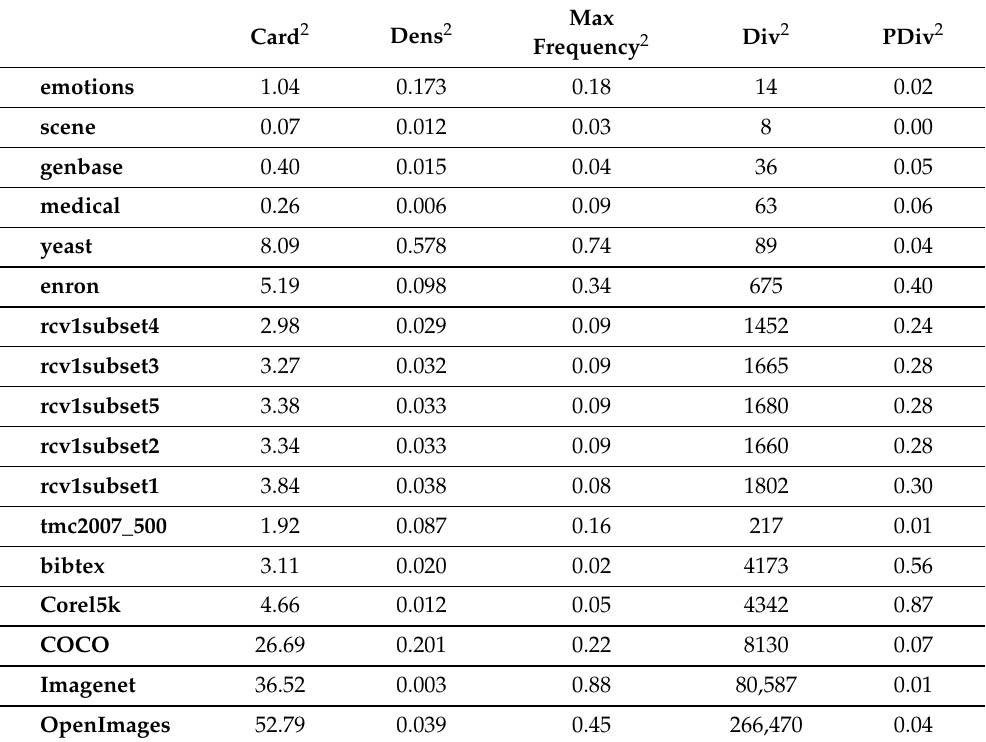
Table 2. Measures of label pair imbalance of different multi-label data sets: label pair cardinality (Card 2 ), label pair density (Dens 2 ), maximum frequency of a label pair (Max Frequency 2 ), label pair diversity (Div 2 ) and normalized label pair diversity (PDiv 2